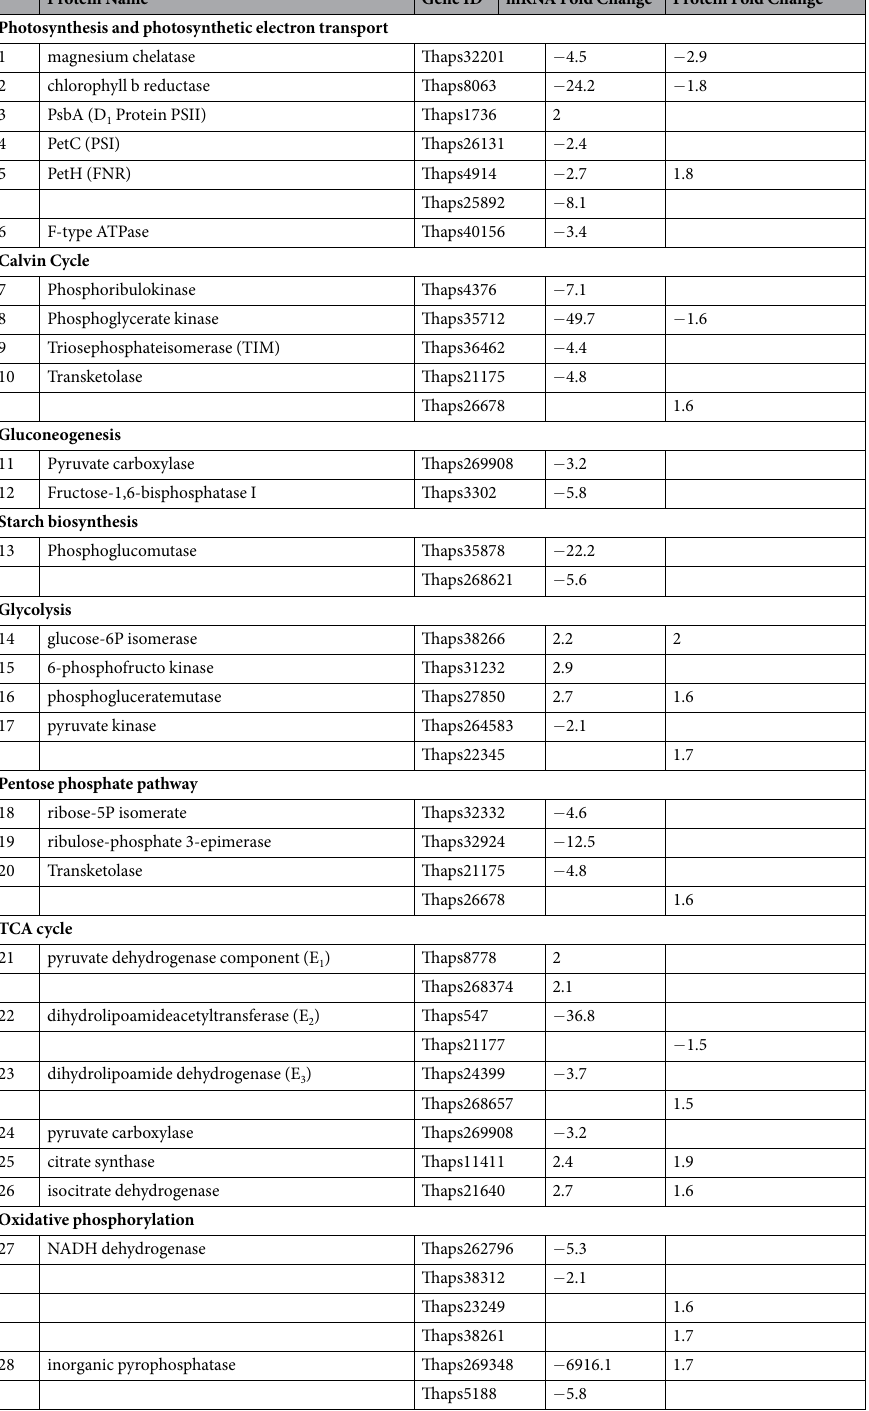
Table 1. The Fold Change of transcrpits and proteins in T. pseudonana under N